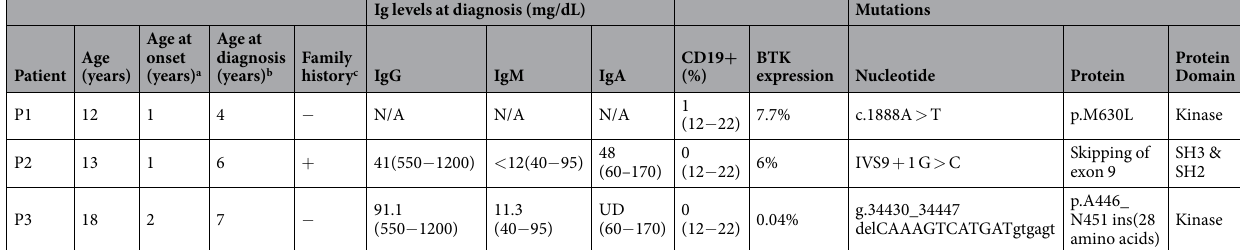
Table 1. Clinical and immunological data of the XLA patients. N/A, not available. UD, undetectable. a Age at the which an individual acquires, develops, or first experiences a condition or symptoms of a disease. b Age at the start of intravenous immunoglobulin replacement. c “ + ”, indicates that family members [boy (s)] died at a young age because of infection. d Normal expression is >